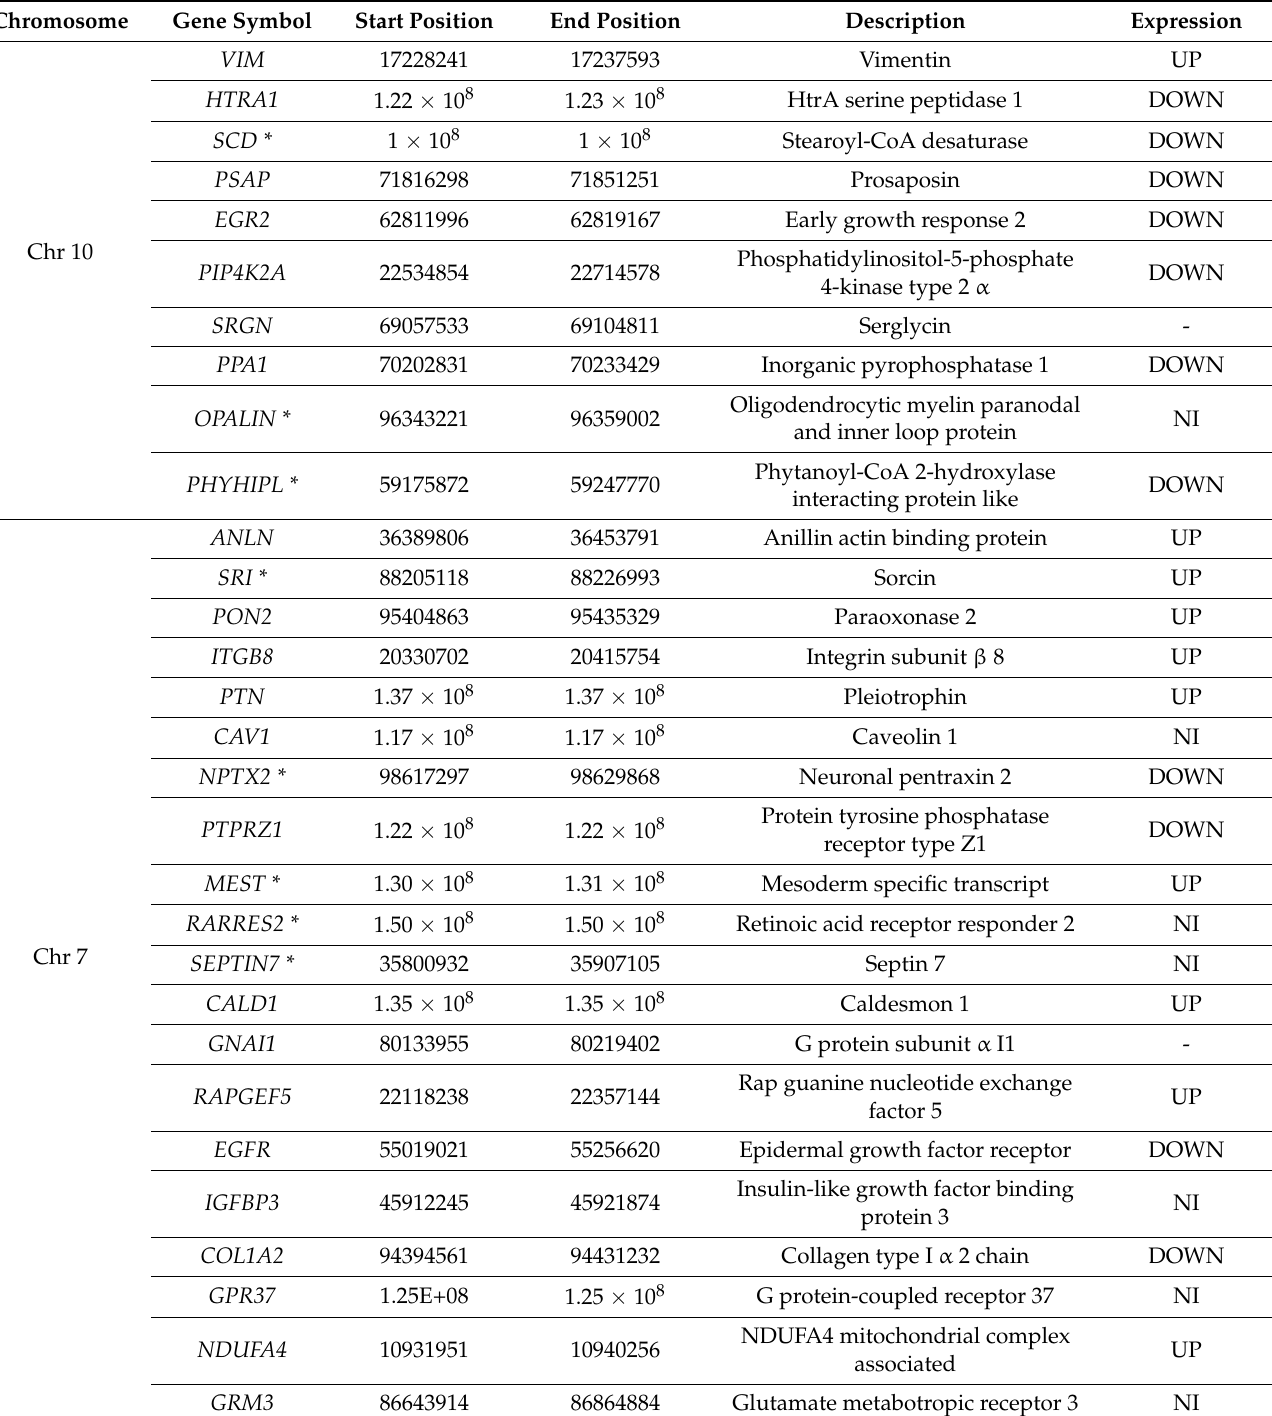
Table 1. Candidate DEGs located on the chromosomes and their expression